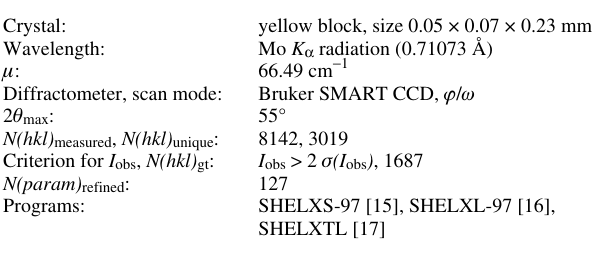
Table 1. Data collection and handling.